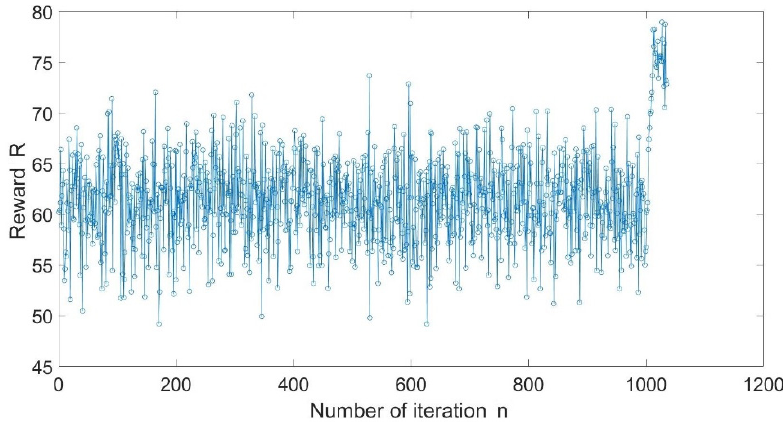
Figure 21. Iteration n vs. reward R for vent panel.